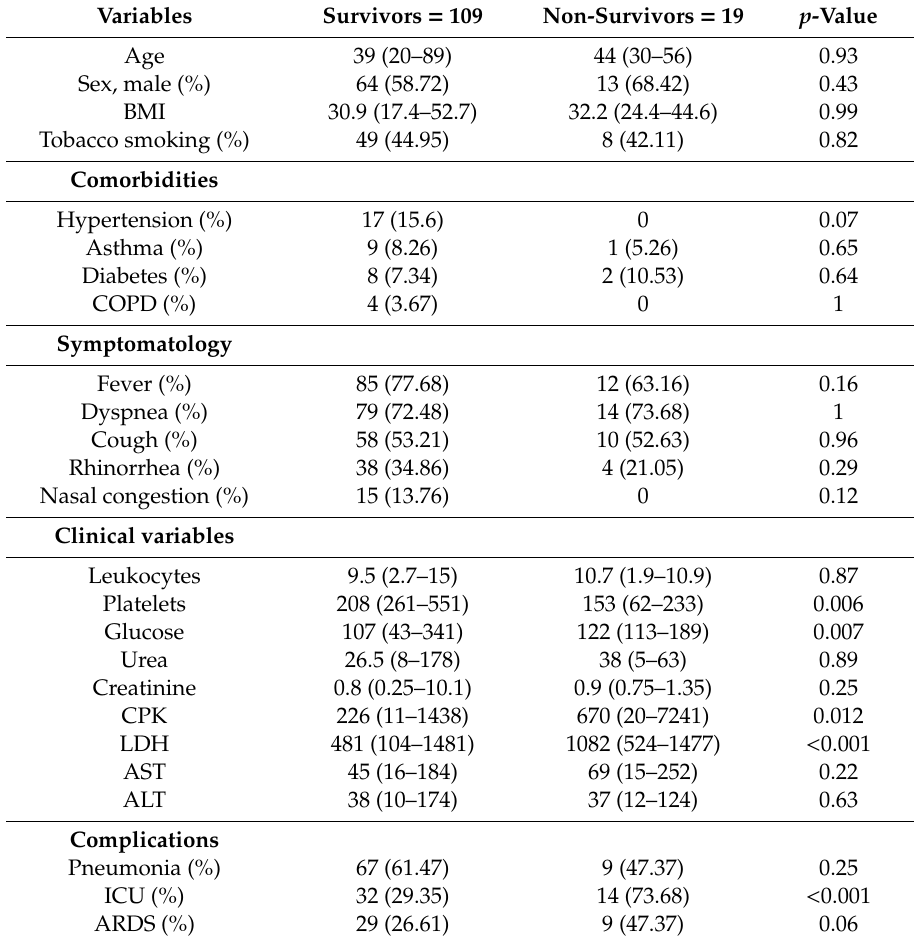
Table A1. Demographic and clinical data of the Survivors and Non-survivors patients from INF-P